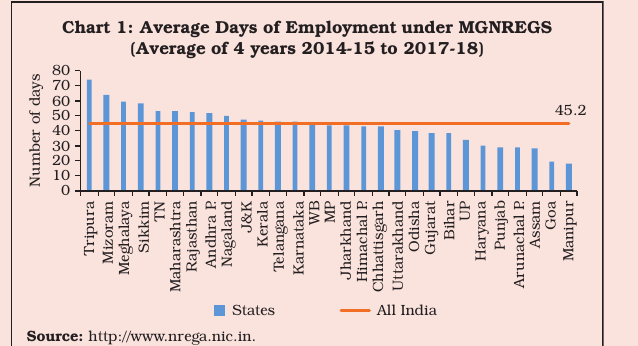
Chart 2: MGNREGS Households Rural Households